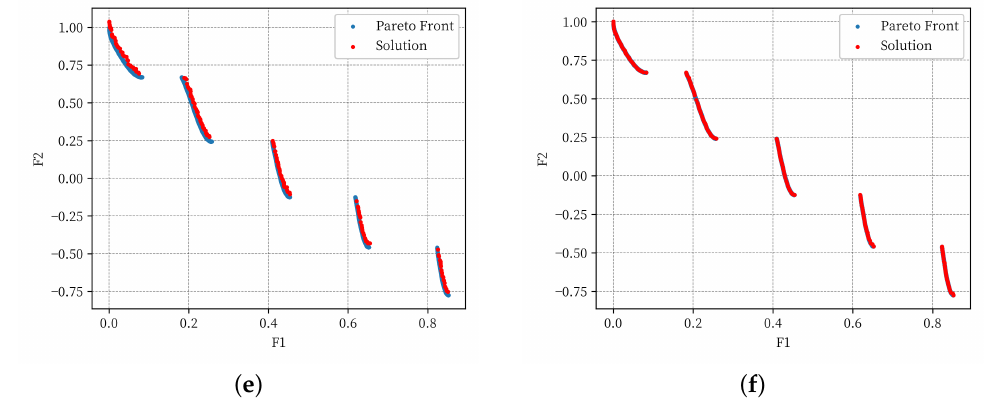
Figure 5. Comparison Between the Pareto Front and the Final Population Solution Set Obtained by the Six Different Algorithms on the ZDT3 Test Problem Set. Subfigures ( a ) AGEMOEA, ( b ) MOEA/D-URAW, ( c ) NSGA-II-SDR, ( d ) CMOPSO, ( e ) MOEA/D-DAE, and ( f ) MOEA/D-DPAW correspond to the running results of algorithms AGEMOEA, MOEA/D-URAW, NSGA-II-SDR, CMOPSO, MOEA/D-DAE, and MOEA/D-DPAW, respectively.